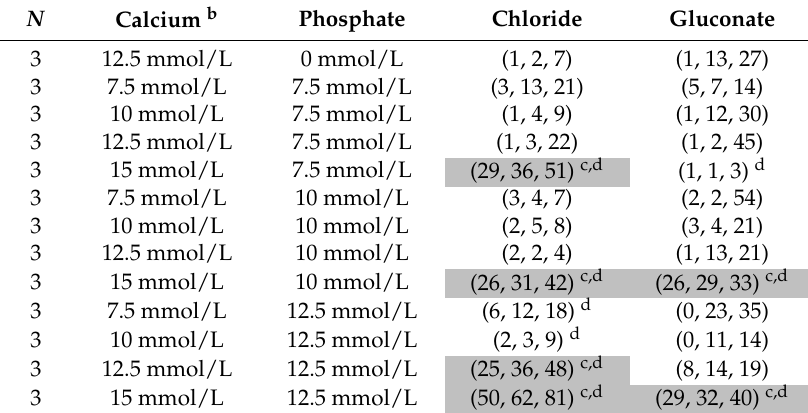
Table 4. Particle counts ≥ 10 microns per mL a for solutions compounded with TrophAmine ( N = number of bags).